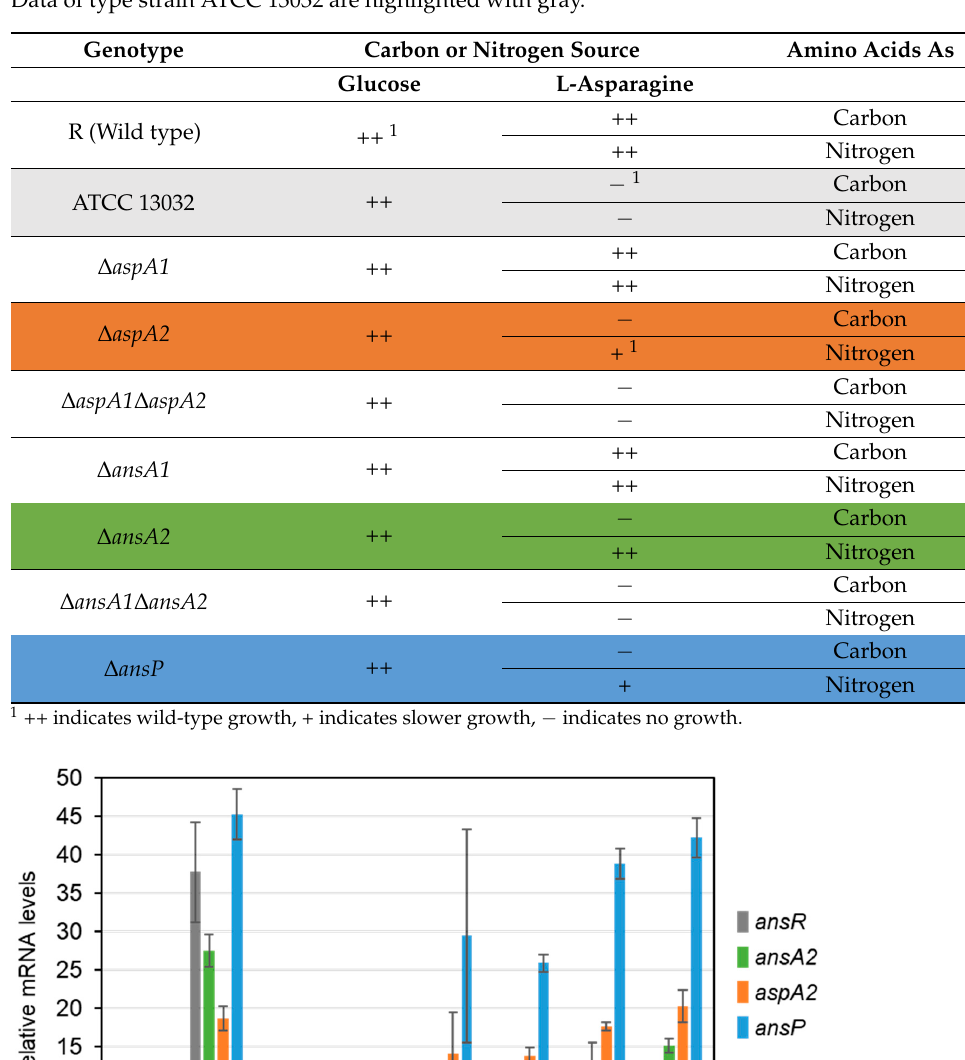
Table 2. Growth properties of strains on glucose or amino acids as a sole carbon or nitrogen source. Cell growth was monitored using optical density at 600 nm for 24 h. Data of deletion mutants of genes in the ans operon are highlighted with the same color as the corresponding genes in Figure 1. Data of type strain ATCC 13032 are highlighted with gray.